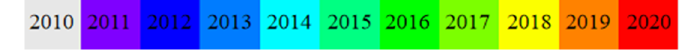
Figure 2. CiteSpace network chart color represents